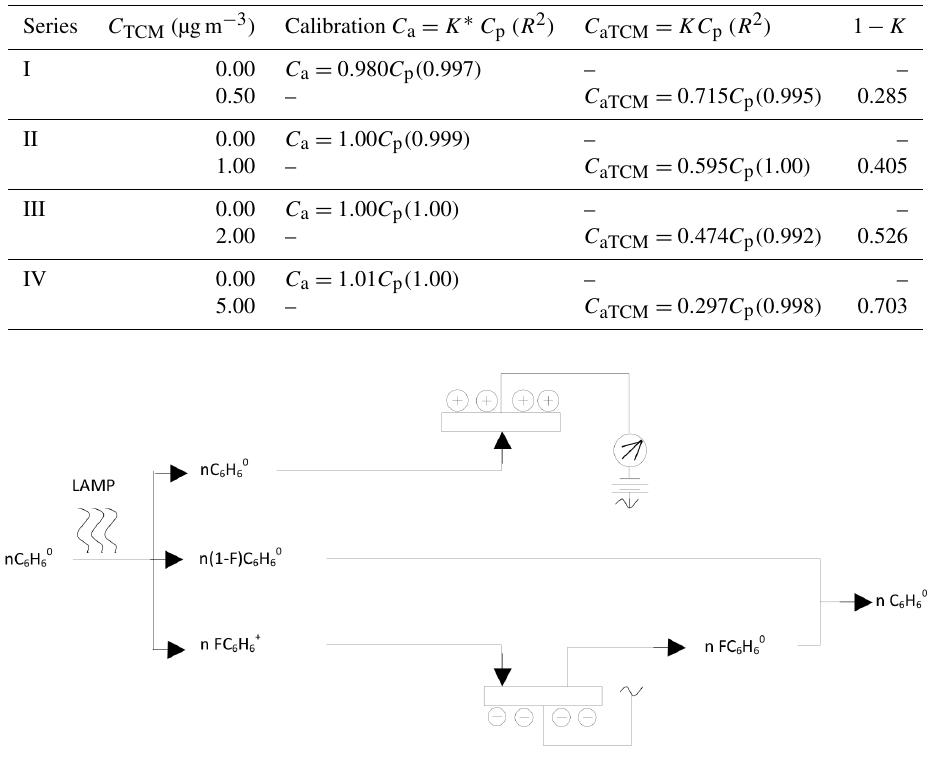
Figure 4. Schematic of the behaviour of benzene in the PID of the chromatograph in absence of TCM.